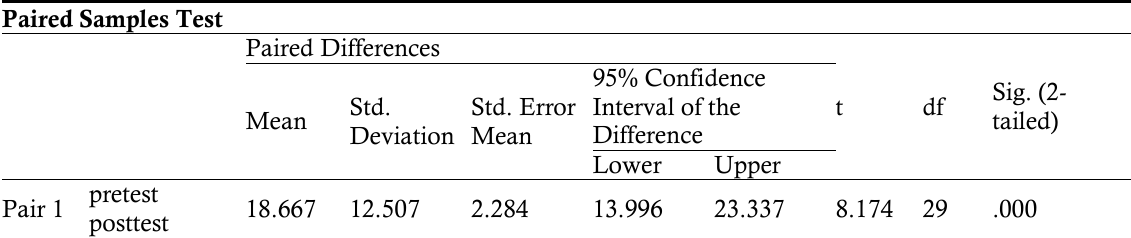
Table 6. Paired sample